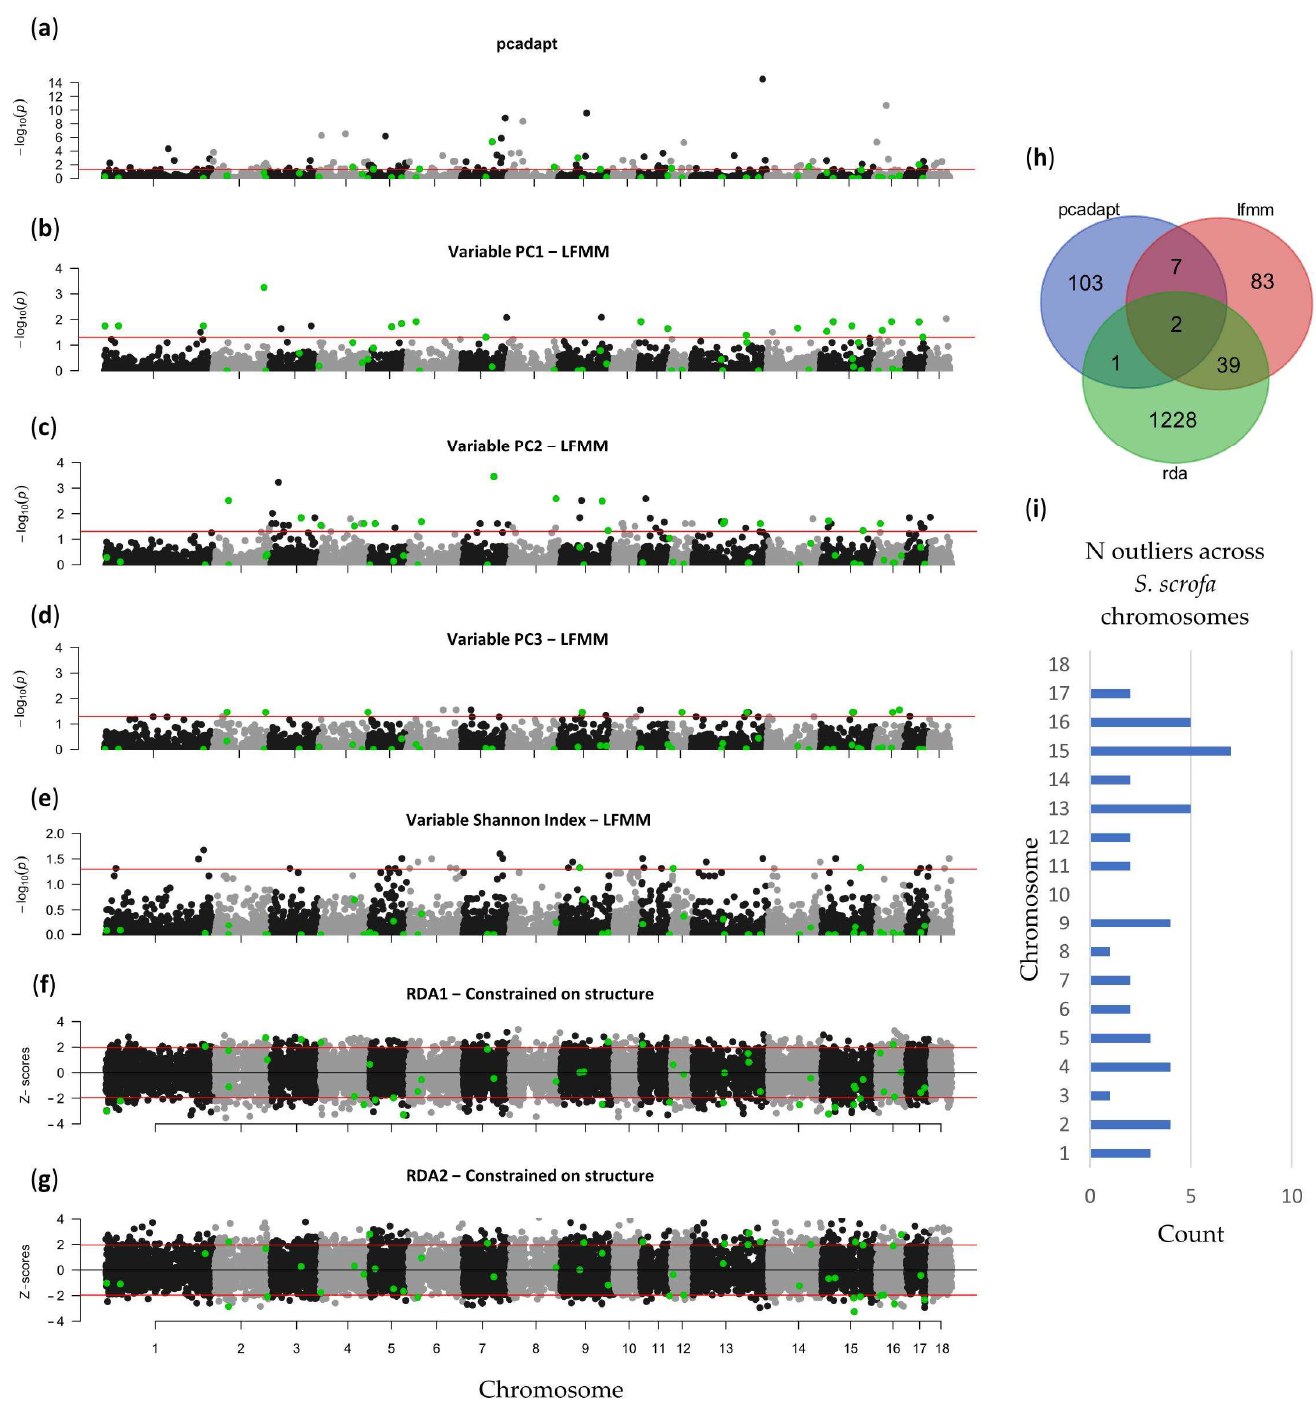
Figure 4. Distribution of test statistics for each SNP of the dataset (13,290 SNPs). ( a ) Manhattan plot of the outlier analysis conducted on pcadapt , considering the first four PCs to correct for population structure. ( b – e ) Manhattan plot of the univariate landscape genomics analyses conducted with LFMM. Results are shown for K = 4 to correct for population structure. As a univariate analysis, each environmental variable is considered separately. ( f , g ) Manhattan plot for the multivariate landscape genomics analyses conducted with constrained RDA to correct for population structure. ( h ) Venn diagram showing the intersection of the SNP outliers identified by the three different methods. Forty-nine SNPs (in green in each Manhattan plot) were identified by at least two methods and thus considered as candidates for local adaptation; ( i ) distribution of the 49 candidate loci across the Sus scrofa